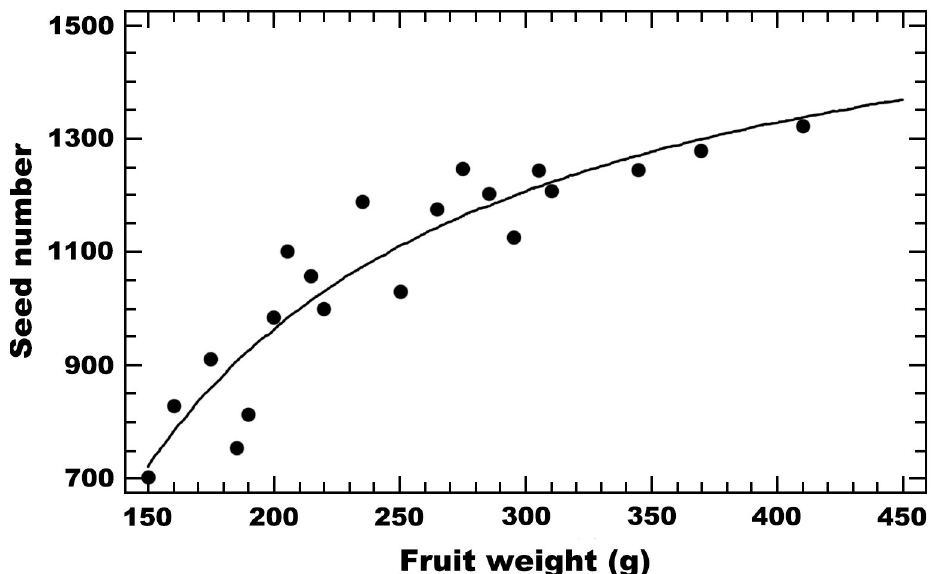
Fig 2. Relation between fruit weight and seed number in eggplant fruit: Seed number = 1691.44 - (145373/ Fruit weight).